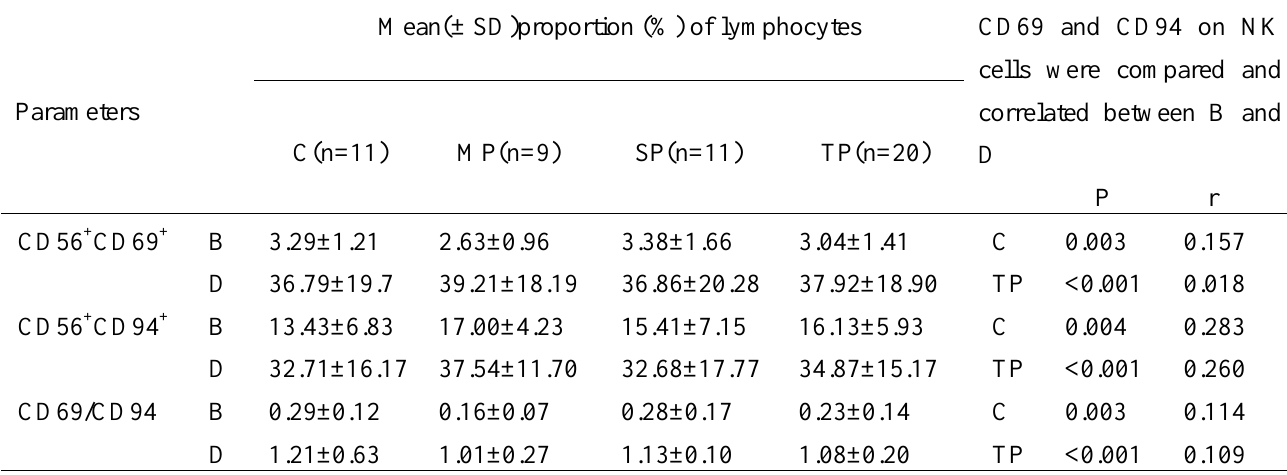
Table 3. Percentages of NK cells receptors: CD69 and CD94 in lymphocytes and ratios of CD69/CD94 in preecalmpsia patients and the controls.